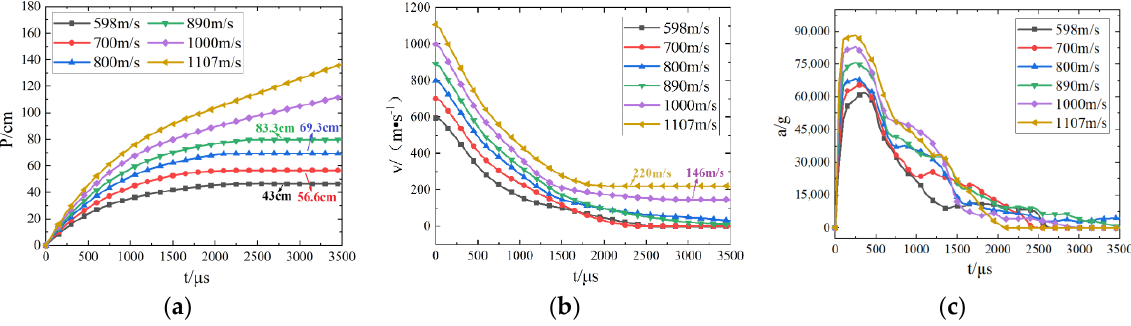
Figure 11. Data of projectile penetrating red sandstone target: ( a ) penetration depth versus time curve; ( b ) penetration velocity versus time curve; ( c ) penetration acceleration versus time curve.